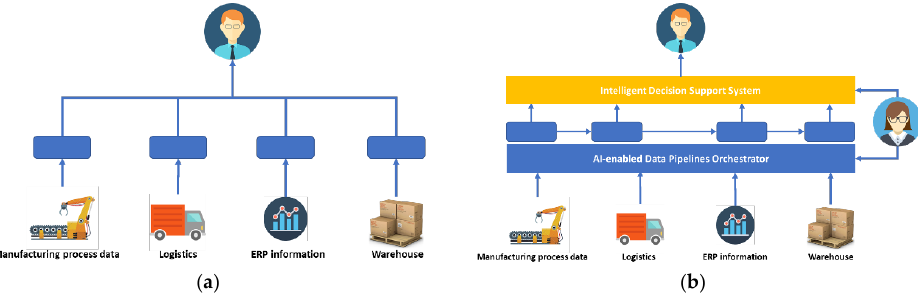
Figure 4. Current ( a ) and system-enhanced ( b ) ZDM solution.